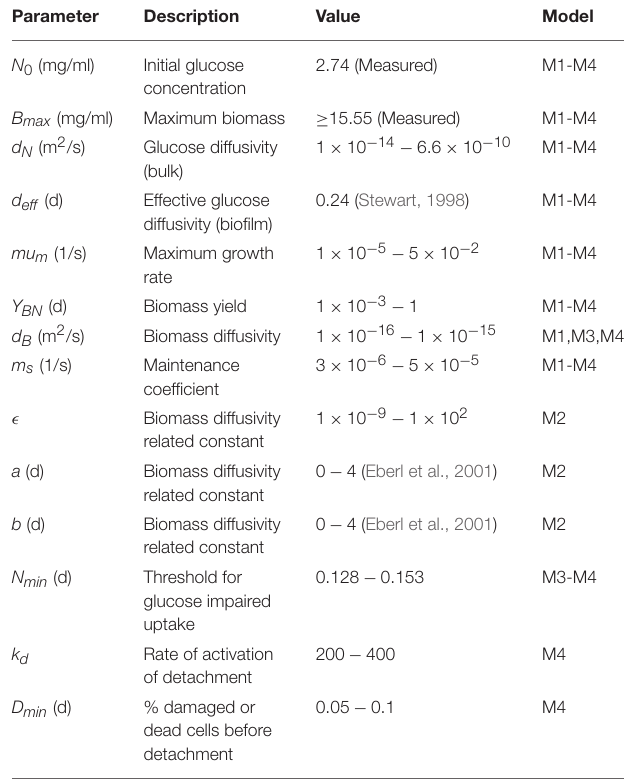
Parameter bounds considered for model identification. (d) Corresponds to dimensionless